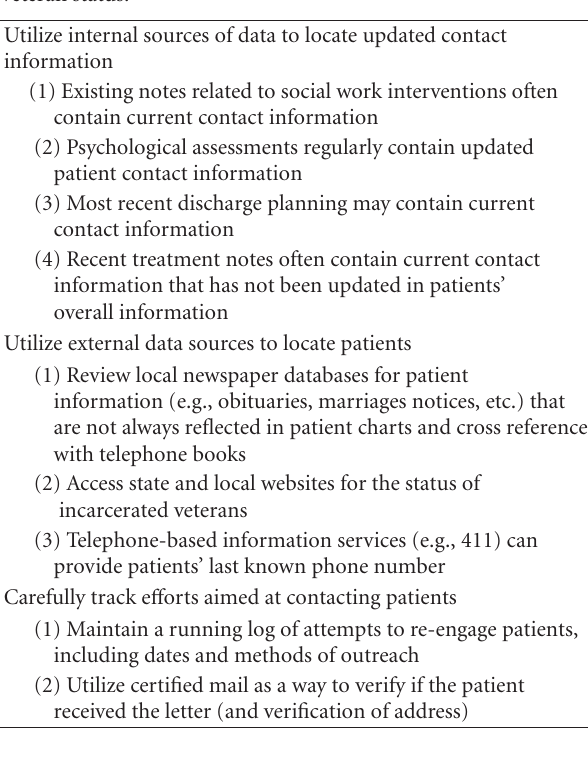
Table 5: Barriers and solutions related to appointment attendance following outreach